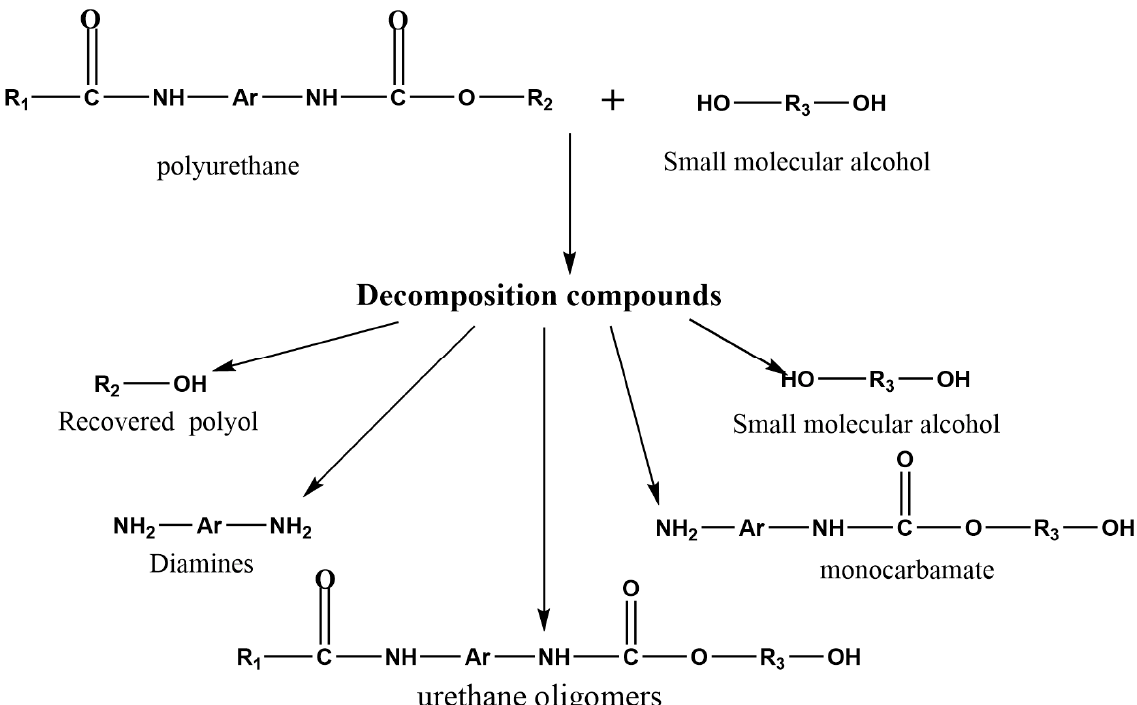
Figure 5. Outline of possible products obtained from the alcoholysis process. The flow of the process of recycling waste polyurethane foam, through its degrada- tion by alcoholysis and subsequent use of the recycled polyether polyols to replace com- mercially available polyether polyols in the production of recycled polyurethane foam, is shown in the Figure 6.